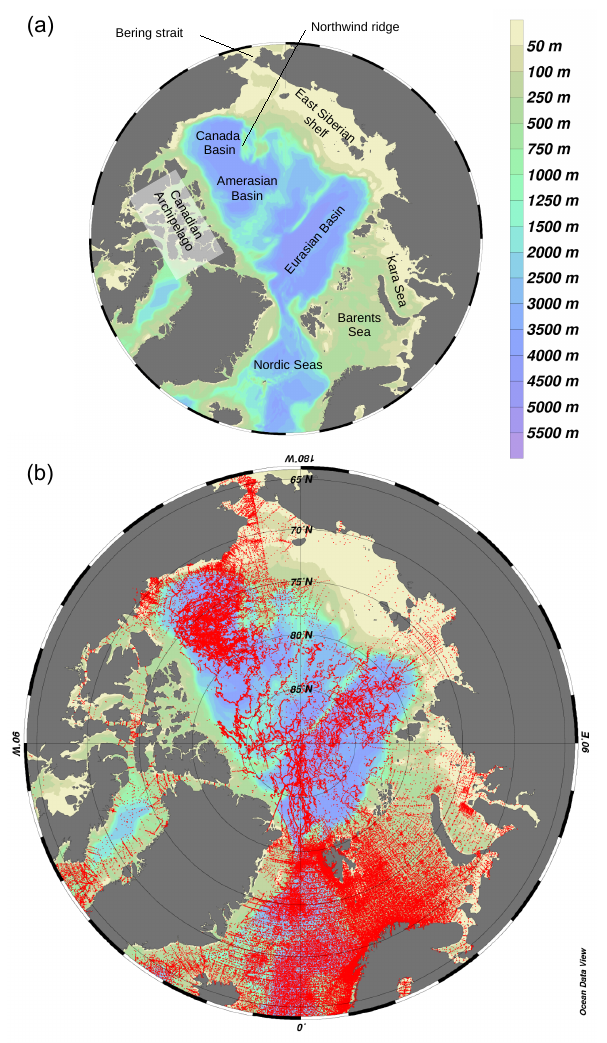
Figure 1. The topographic features of the Arctic Ocean (a) and spa- tial distribution of archived temperature and salinity data for the 1980–2015 period (b) ; a red dot is shown if there is at least one measurement in the 0–20m depth range.